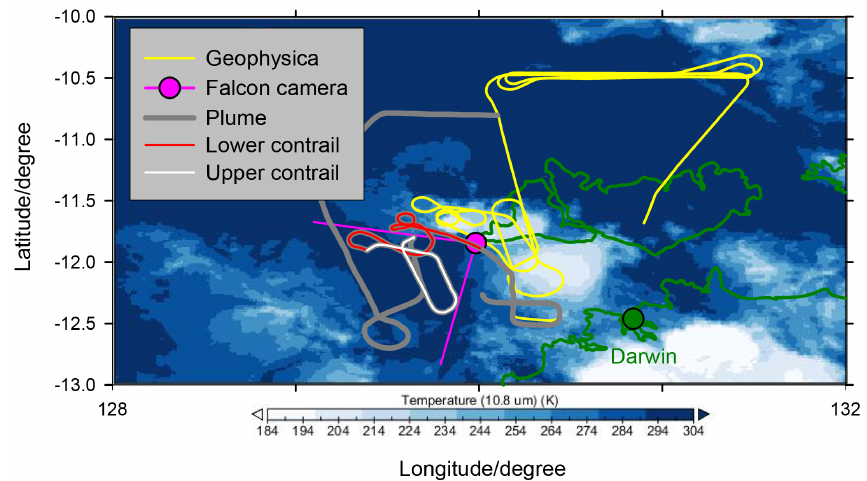
Figure 4. Falcon camera view directions above 10.8µm brightness temperature image from NOAA-12 AVHRR at 08:28:53UTC 16 Novem- ber 2005. Yellow curve: Geophysica flight path until 08:35UTC; dark gray: computed plume position. Overlaid white and red lines are the positions of the upper and lower contrail parts seen in the photo. Green symbol/line: Darwin and the coast line. The minimum brightness temperature over Hector is 203K at this